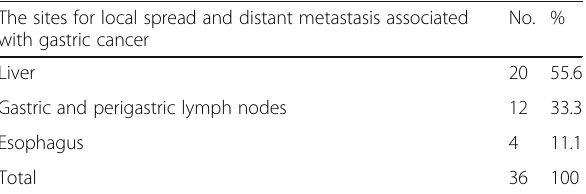
Table 1 Shape of gastric cancer by MDCT Shape of gastric cancer by MDCT